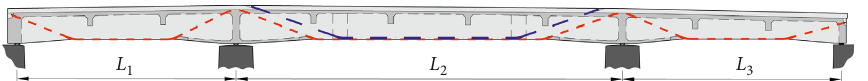
Figure 4: The basic scheme of cable arrangement in the case of strengthening a continuous span bridge by post-tensioning using the substitute cable duct method. Also, it is an example of the usage of multiple phases of post-tensioning. The first phase (on the picture described by red dashed lines) creates a possibility for casting an additional concrete composite slab for slab strengthening. The second phase (on the picture described by blue dashed lines) increases the overall load-bearing capacity of the critical middle span.